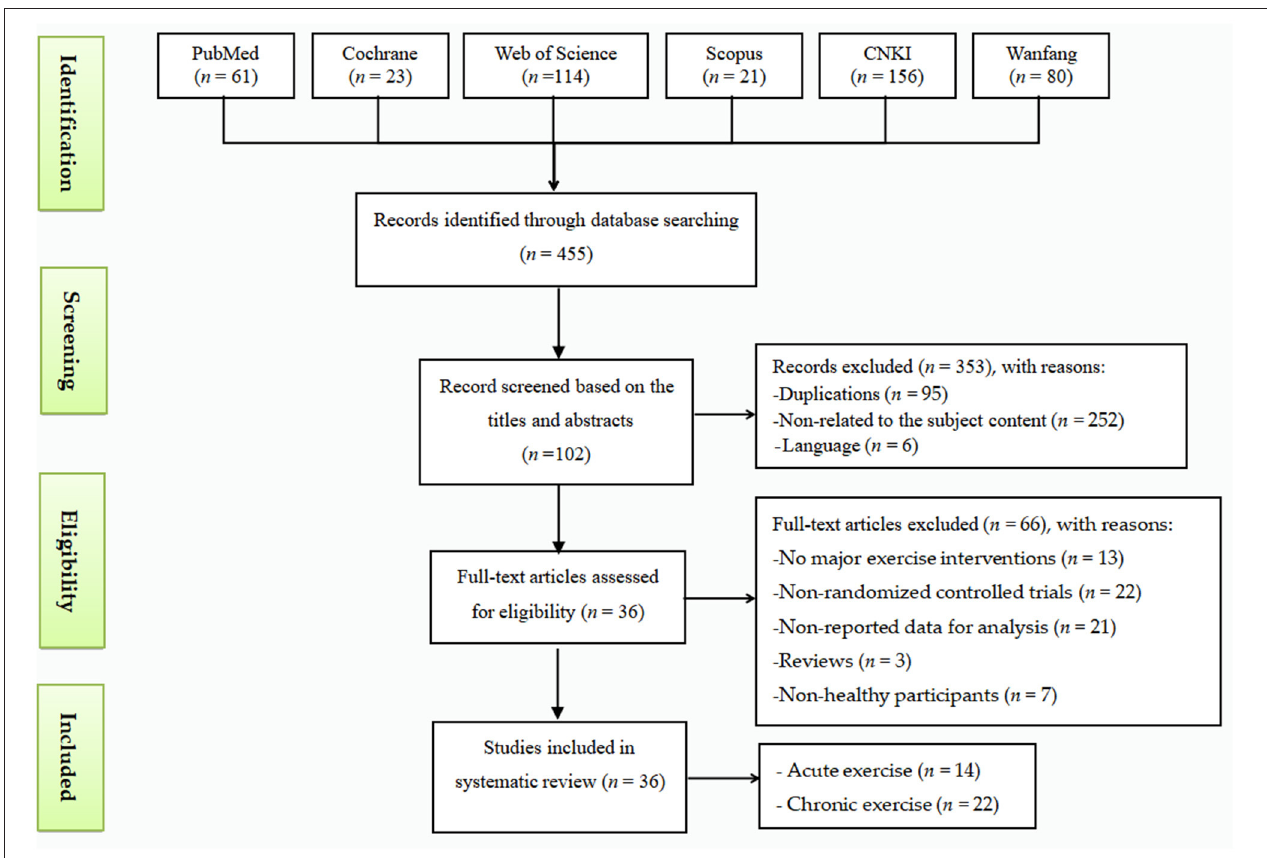
FIGURE 1 | Flow of the study selection